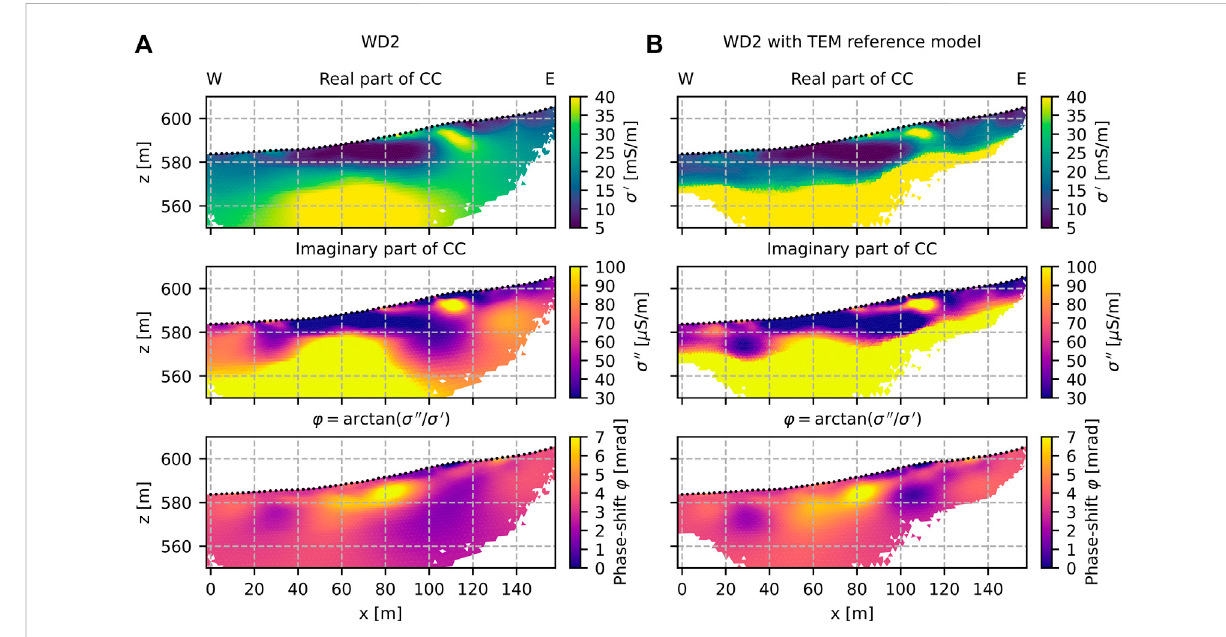
FIGURE 3 Complex conductivity imaging results for the pro fi le WD2 expressed in terms of the real σ ′ and imaginary σ ″ component of the complex conductivity σ p as well as the phase-shift φ for (A) “ standard ” inversions without the incorporation of complementary information and (B) for inversions performed with a reference model based on TEM data collected along WD2.